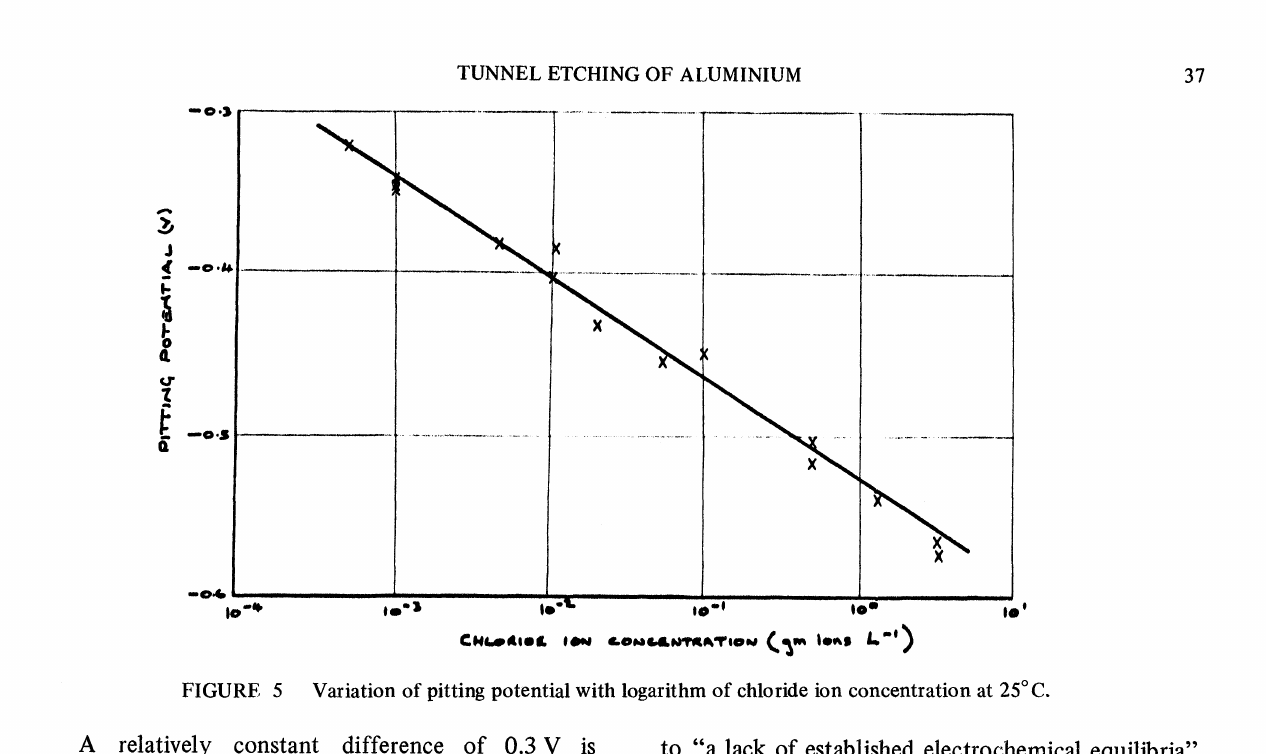
FIGURE 5 Variation of pitting potential with logarithm of chloride ion concentration at 25